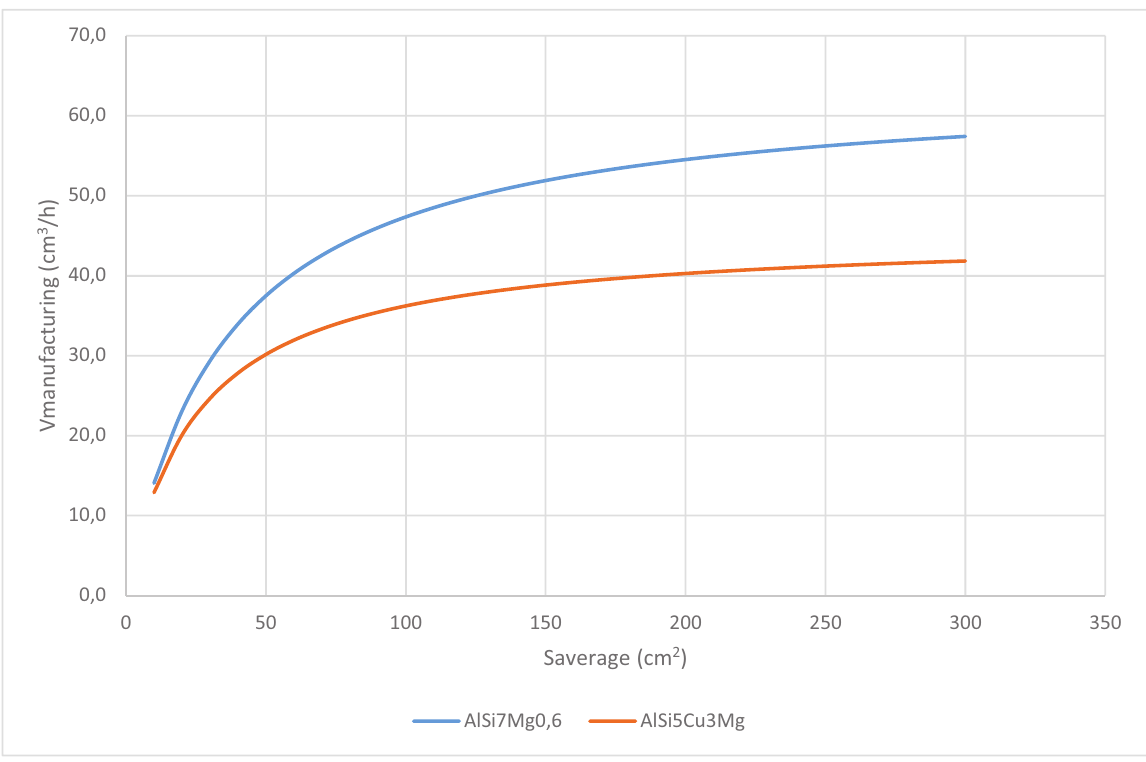
Fig. 16. Comparison of the manufacturing speeds of the AlSi7Mg0.6 and AlSi5Cu3Mg